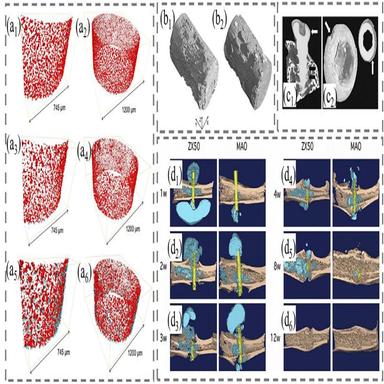
Corrosion processes in different Mg alloy implants: (a1–a6) distribution of the pores and particles in the coatings ; (b1, b2) Mg alloys implant corrosion with/without MgF2 layers ; (c1, c2) an explanted Mg screw after 6 months ; (d1–d6) ZX50 alloys with/without micro-arc oxidation treatment in leg bones .